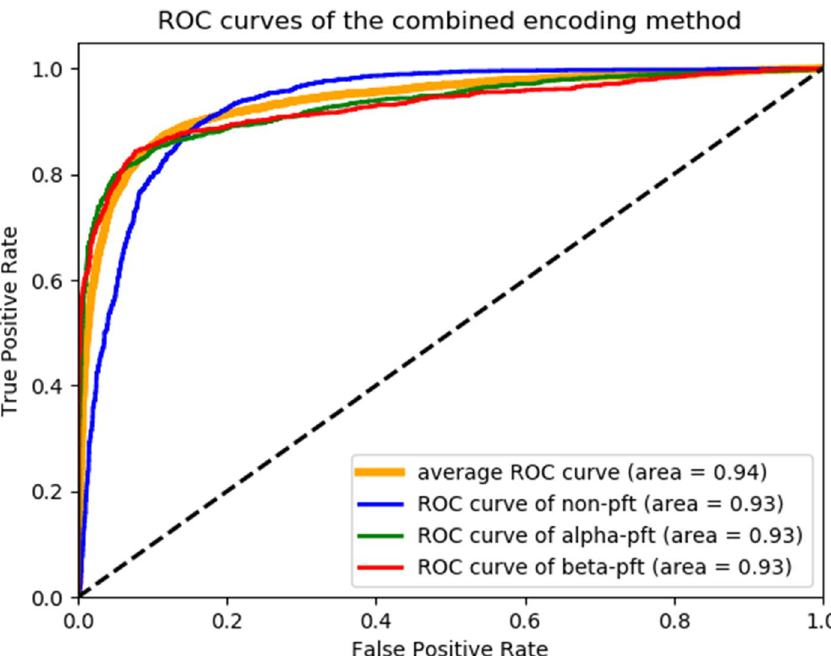
Figure 4. Receiver operating characteristic curves of the combined encoding method. We show the curves for the negative, alpha, and beta pore formers, as well as the average ROC curve.